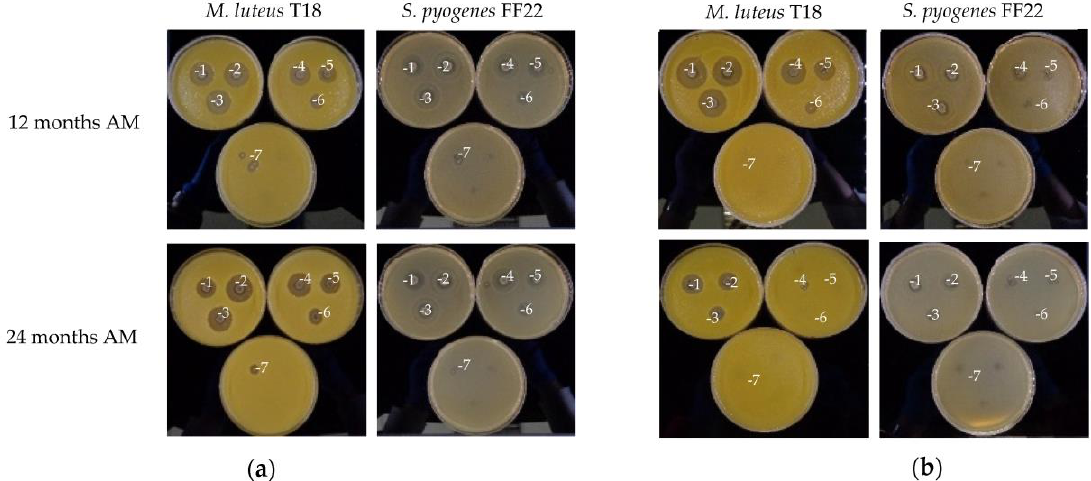
Figure 2. Inhibitory activity of Bactoblis ® ( a ) and Daily Defence-BLIS K12 TM ( b ) at 12 and 24 months AM. The inhibitory activity was determined by the agar spot method, using Micrococcus luteus T18 and Streptococcus pyogenes FF22 as indicator strains. The numbers represent the decimal dilutions of each tested sample.